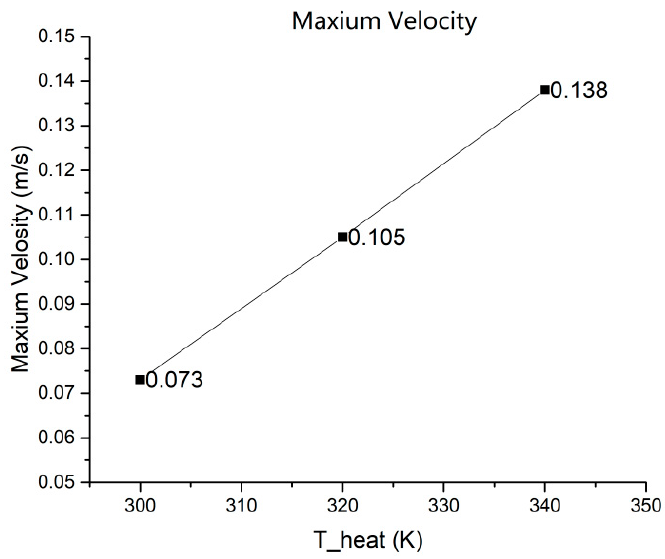
Figure 3. Velocity distribution in the microvalve under different heating conditions.